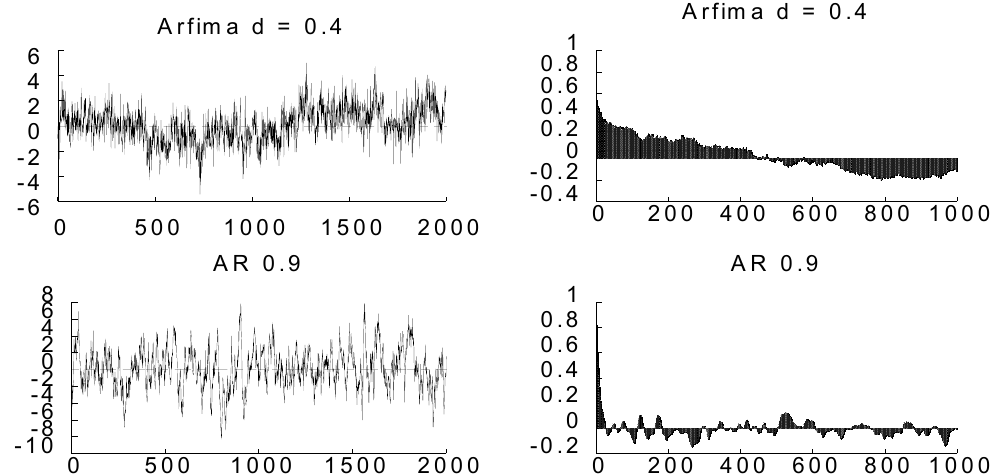
Figure 1. Plot of Time Series. The top-left (ARFIMA d = 0.4) and bottom-left (AR 0.9) figures show the simulated series for an autoregressive fractionally integrated process with a fractional parameter d = 0.4 and an autoregressive process with a lag parameter equal to 0.9, respectively. The right-hand side shows the corresponding correlogram with 1000 lags. The correlogram shows that the autoregressive process (top right) declines geometrically to zero unlike the ARFIMA process (bottom right).